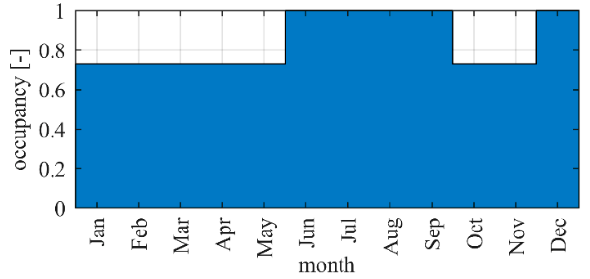
Figure 3. Annual occupancy profile of the overall building.